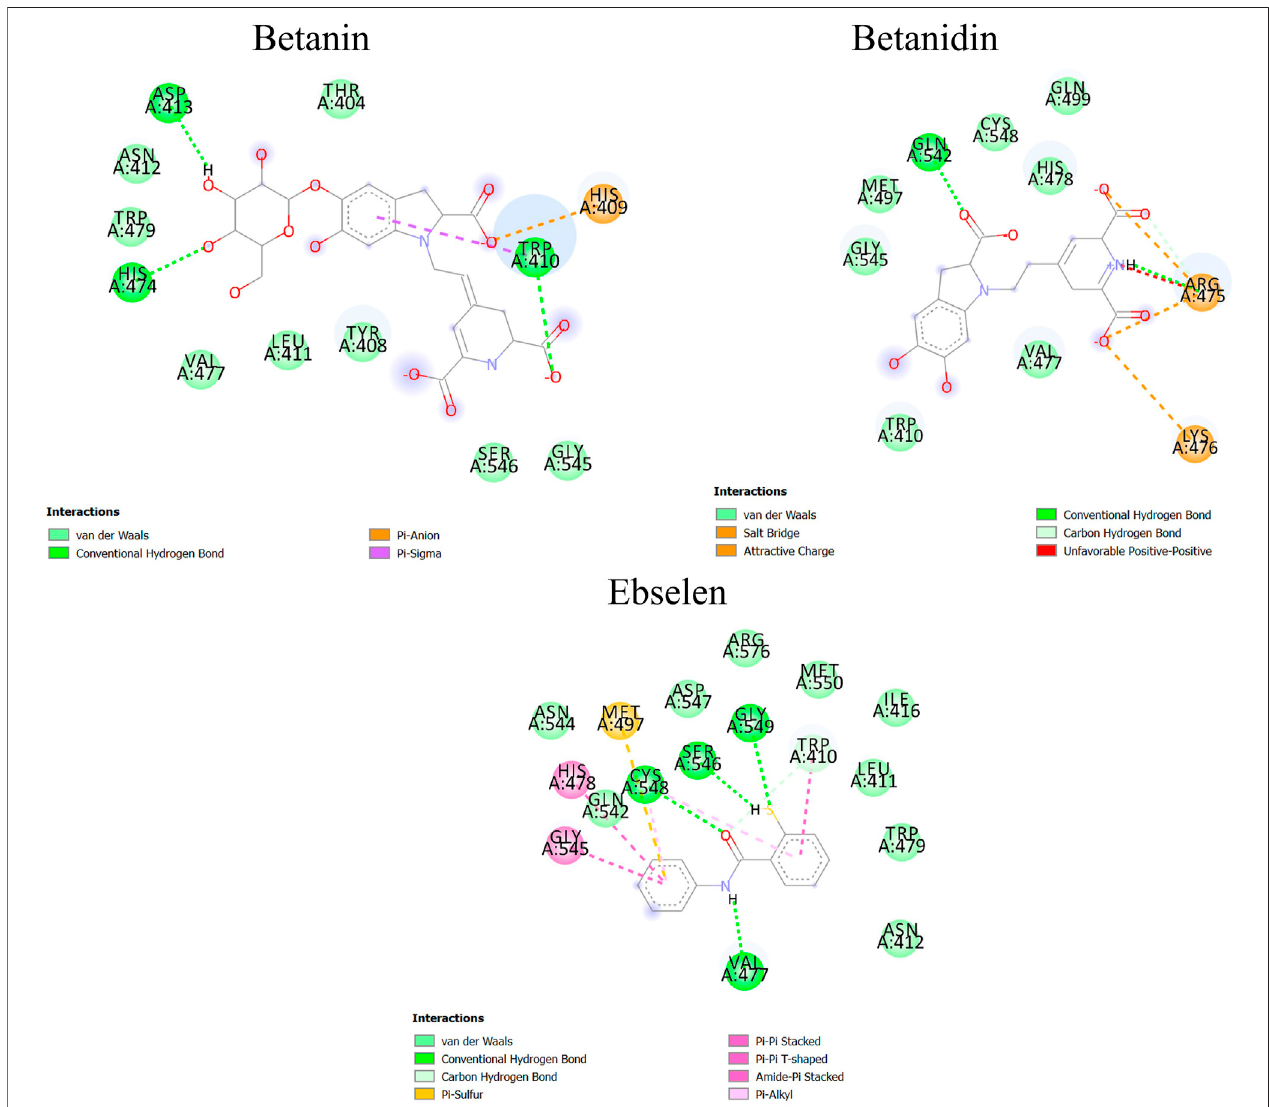
FIGURE 6 | Binding between Betanin, Betanidin, and Ebselen with SENP2 by Discovery Studio after molecular dynamics simulation (2D structures).